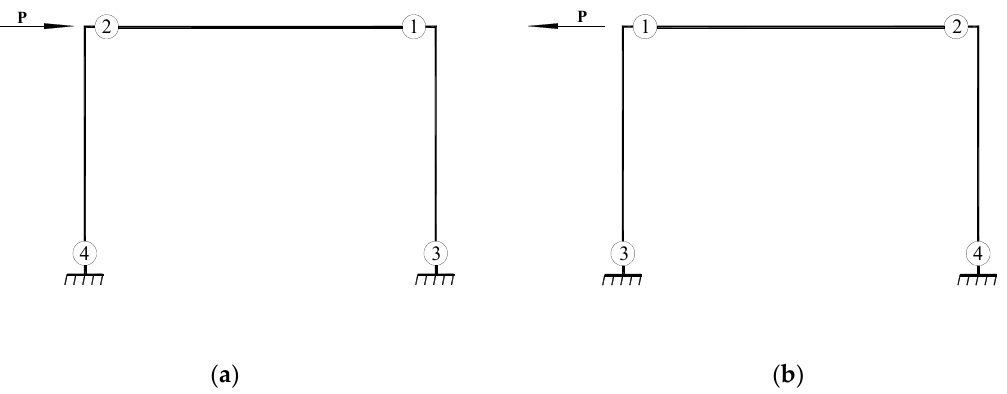
Figure 7. The sequence of the plastic hinges of the test frame under ( a ) positive loading and ( b ) negative loading.